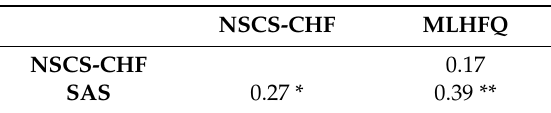
Table 3. Pearson correlation.